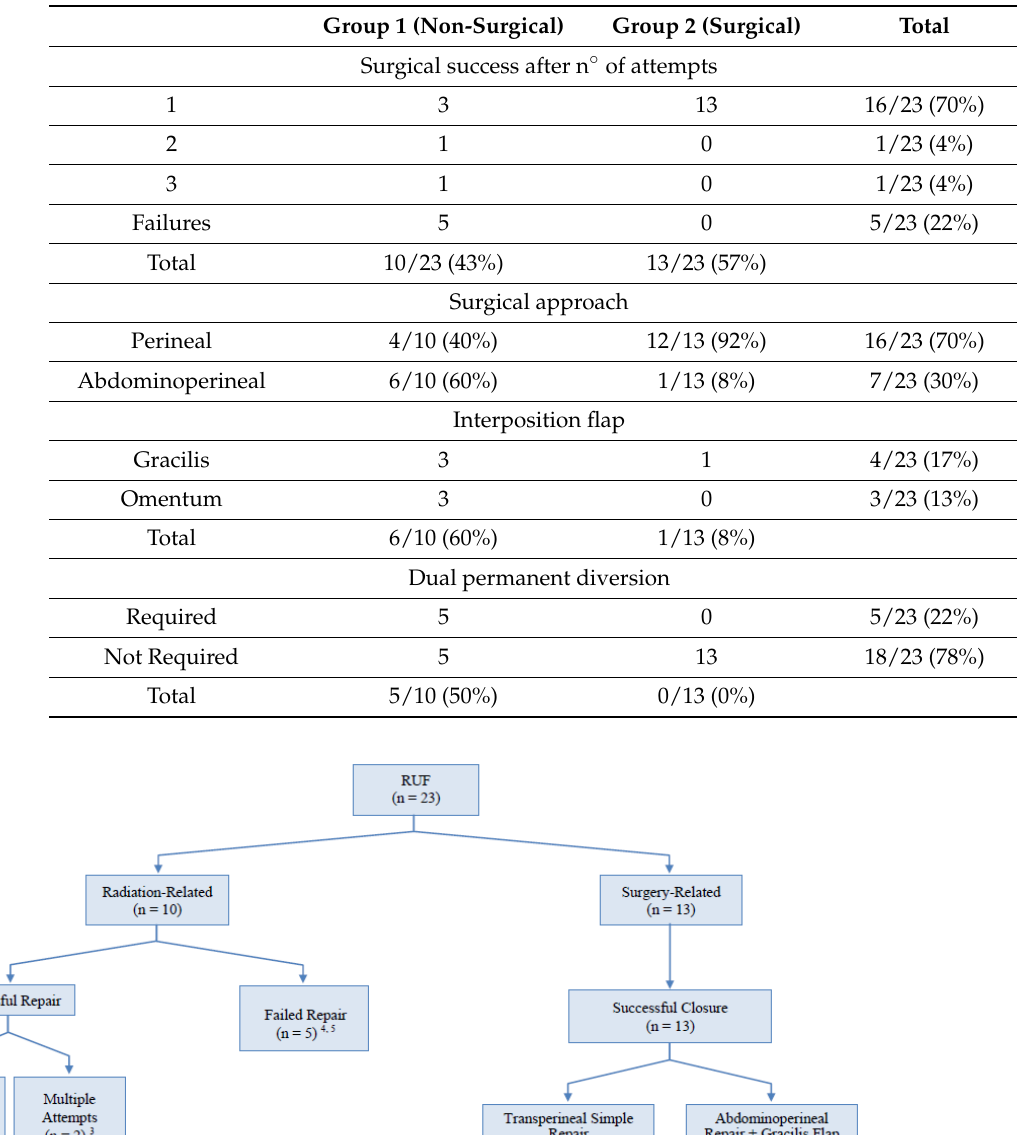
Table 3. Surgical outcomes according to patient clinical characteristics.